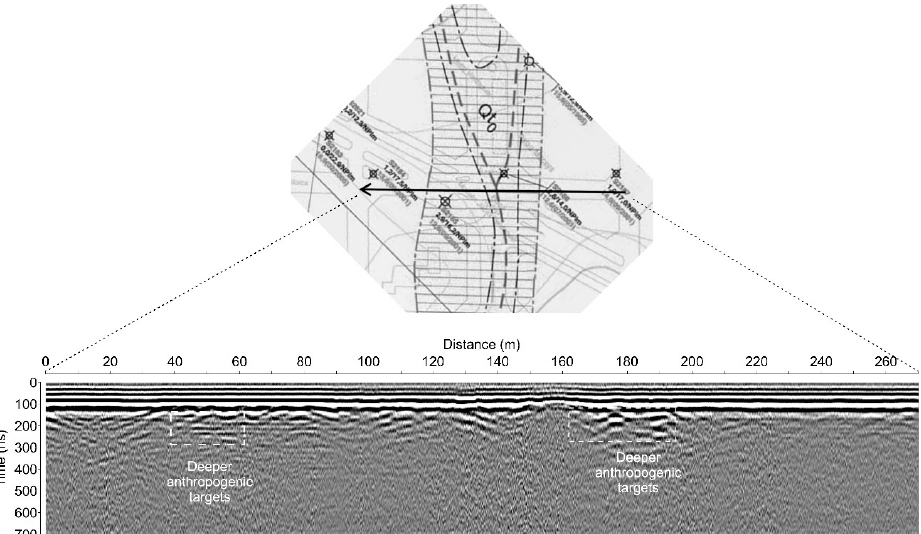
Figure 4. Radar data along 270 m, showing the maximum two-way travel time (TWT) recorded for reflections on anthropogenic targets. The radar line crosses one subterranean stream in the area where the background noise at the B-scan is increased (between 120 m and 160 m).